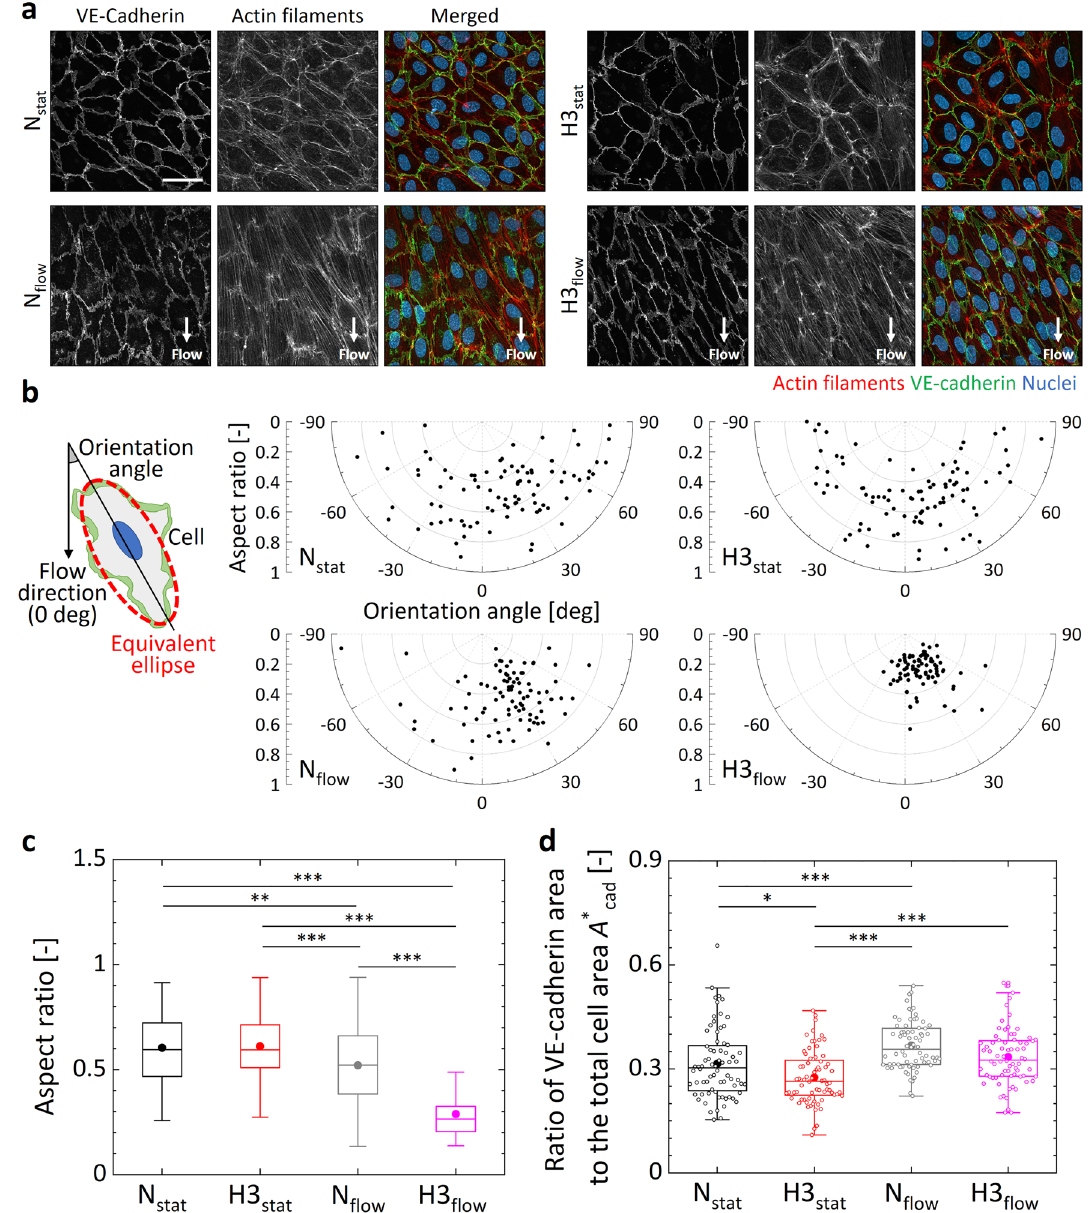
Figure 5. Morphological changes of ECs in the monolayer after 6 h of exposure to the four different oxygen and flow conditions N stat , H3 stat , N flow , and H3 flow . ( a ) Representative images of maximum intensity projections of confocal microscope images of ECs to the xy -plane. Scale bar shows 40 μm. ( b ) Orientation angle and aspect ratio of 90 cells from three devices. ( c ) Box-and-whisker plots of the aspect ratio of the cells. The upper and lower extremes represent the maximum and minimum values, the box plot represents quartiles, and the band and dot inside each box show the median and average value, respectively. ( d ) Box-and-whisker plots of the ratio A * cad of the VE-cadherin area to the total cell area with the raw data plotted. The metric was measured with 72 cells from three devices for each condition. Significant differences in the metrics at different oxygen and flow conditions were assessed by 2-way ANOVA followed by Tukey’s post-hoc tests for multiple comparisons. * P < 0.05; ** P < 0.01; *** P <